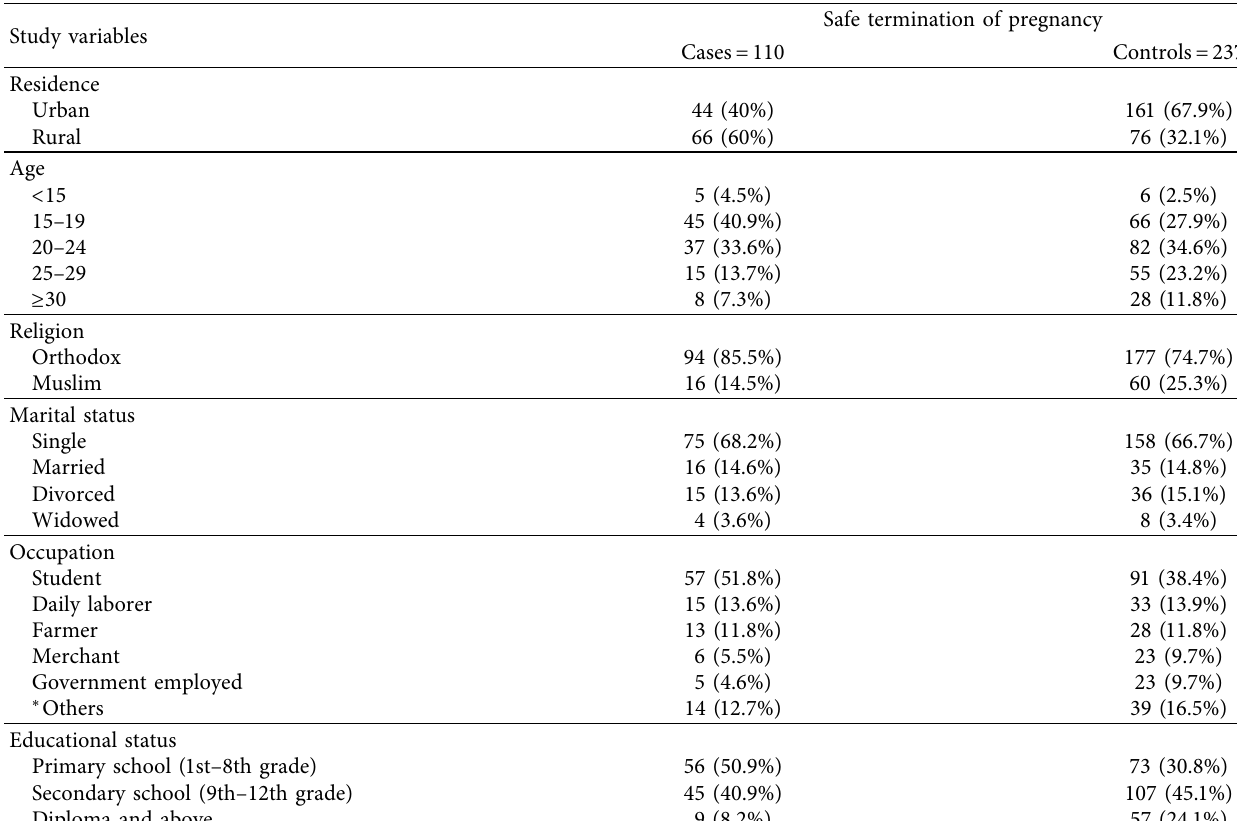
Table 1: Sociodemographic characteristics of participants who came for safe termination of pregnancy, Amhara region, northwest Ethiopia, 2020 ( N � 347).